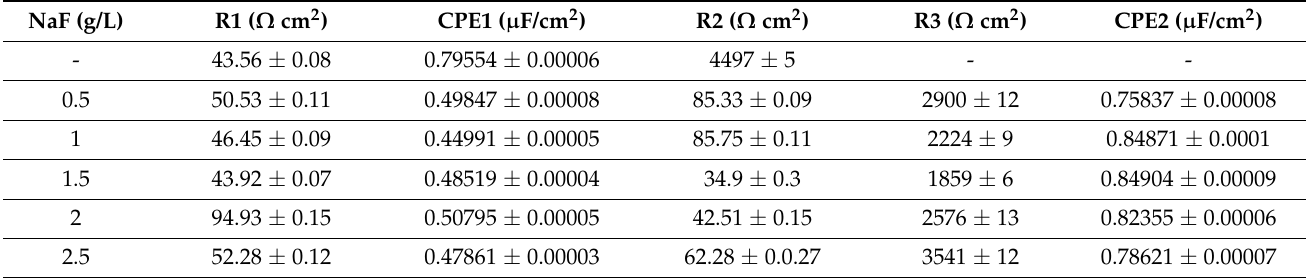
Table 2. The results of the EIS curves of the Zn-Mn-Mg alloys and fabricated by the MAO with different NaF concentrations from 0.5 g/L to 2.5 g/L in Hank’s solution at 37 ◦ C.